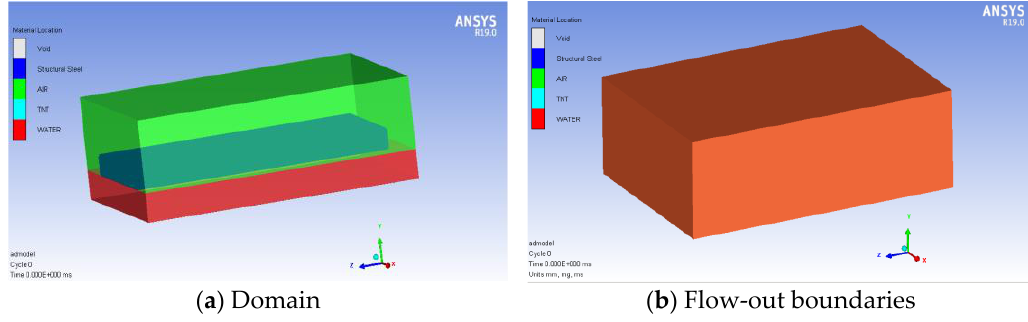
Figure 3. The domain and boundaries of the ferry.